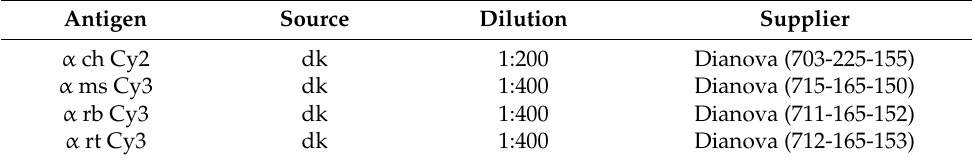
Table 4. Secondary antibodies used for immunohistochemistry of tissue sections. List of secondary an- tibodies applied for immunohistochemistry. Supplier: Dianova, Hamburg, Germany. Abbreviations: ch, chicken; dk, donkey; ms, mouse; rb, rabbit; rt,